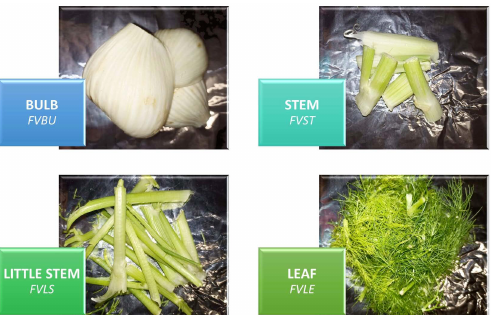
Figure 3. F. vulgare parts analyzed: FVBU ( F. vulgare bulb), FVST ( F. vulgare stem), FVLS ( F. vulgare little stem) and FVLE ( F. vulgare